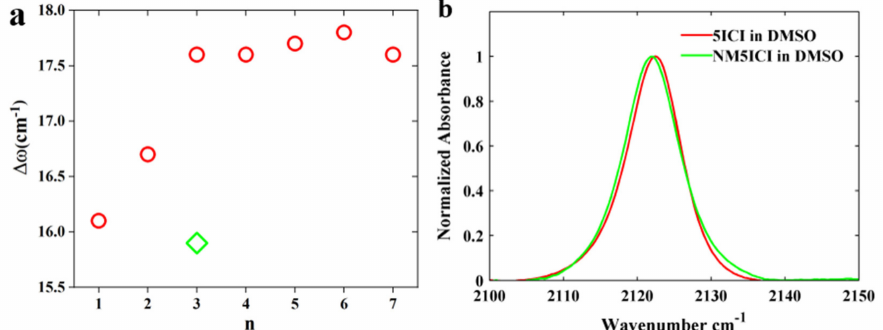
Figure 5. ( a ) The peak separation between the NC stretching frequencies of non-H-bonded and H-bonded NC groups in alcohol solutions versus the carbon chain length ( n ) of the alcohols. ( b ) Comparison of the NC stretching mode of 5ICI and NM5ICI in